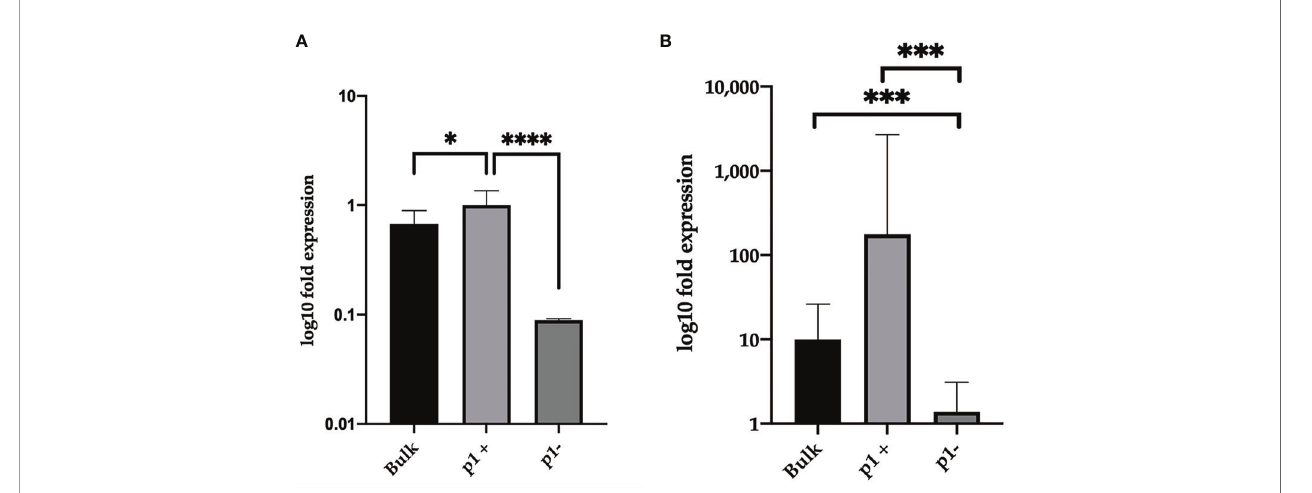
FIGURE 3 | Relative expression of CD5 in p1 positive and p1 negative CLL clones of CLL1 and CLL5 patients. Relative CD5 gene expression in B-CLL subpopulations of CLL1C (A) and CLL5C (B) sample. Bulk represents the total CLL population, p1-positive the sorted VH1-69 CLL cells, and p1-negative the remaining CLL cells. The results, normalized to the GAPDH housekeeping gene and determined by DD Ct method, are represented as log10 fold expression ± SD of triplicate assessments. Statistical signi fi cance was evaluated using one-way analysis of variance (ANOVA), followed by Bonferroni ’ s test for multiple comparisons. Bars show mean values±95% con fi dence intervals based on three biological replicates. *P ≤ 0.01; ***P ≤ 0.001; ****P ≤